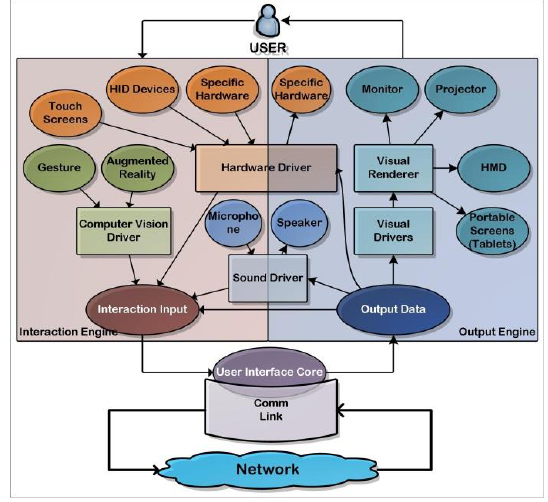
Fig. 18. Architectural elements for the visual interface to a distributed spacecraft simulation.